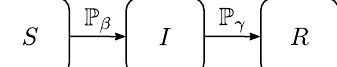
Figure 3. Scheme of the generic epidemic spread model. Each agent can be assigned to a disease state (S, I, R). If a susceptible agent is in contact with an infected agent, with (transition) probability P β , the agent becomes infected. At the end of the day each infected agent has a (transition) probability P γ to